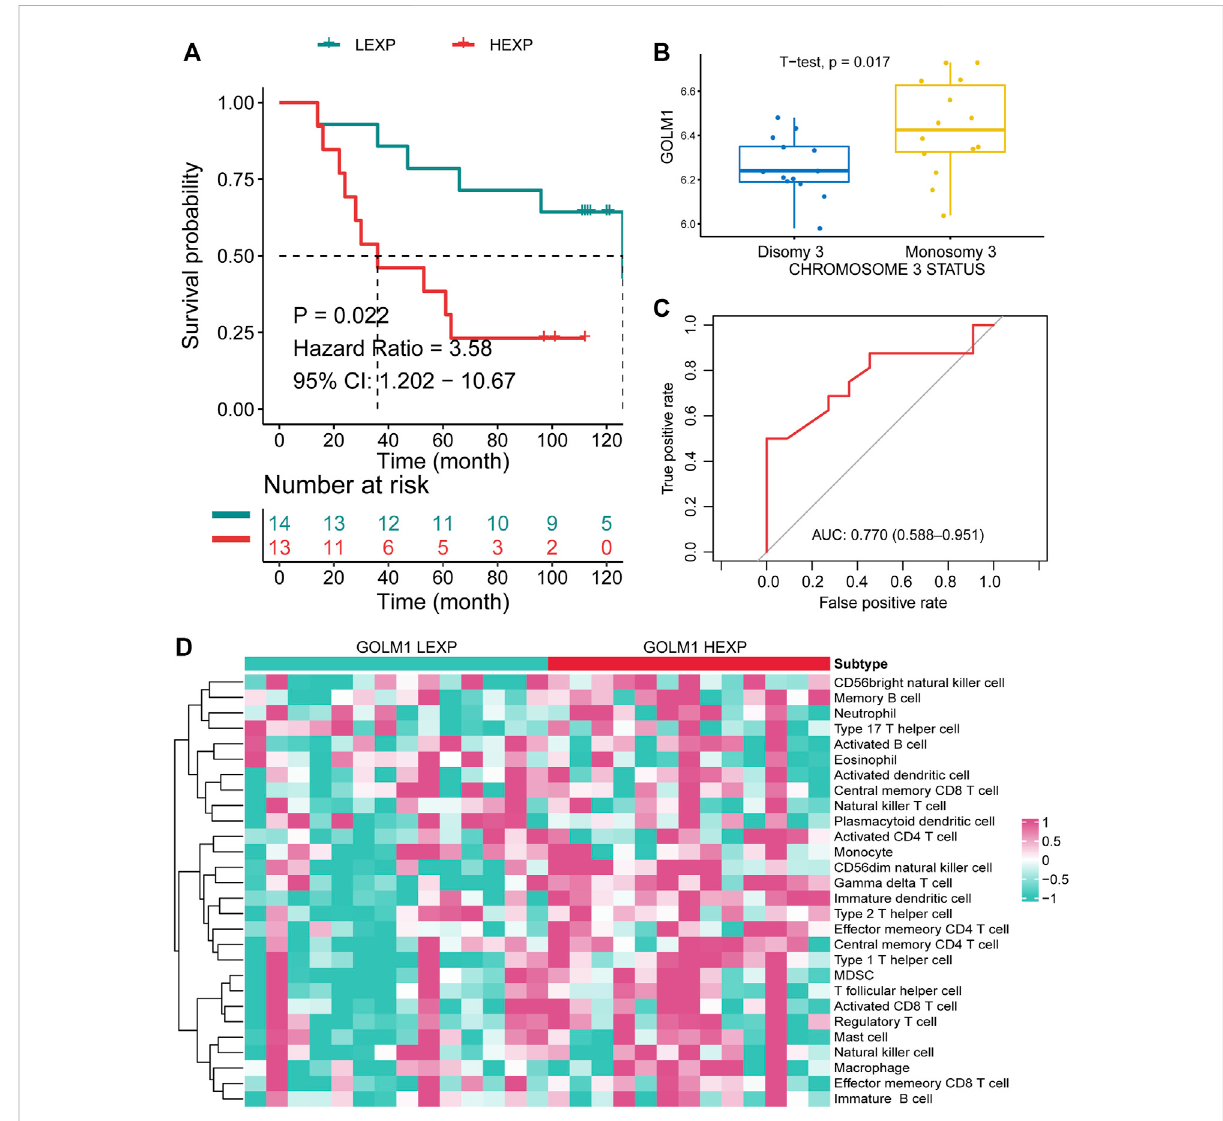
FIGURE 6 Con fi rmation of the prognostic value of GOLM1 in the GSE84976 cohort. (A) Kaplan – Meier curve showing the polarized overall survival in GOLM1-low (LEXP) and GOLM1-high (HEXP) subgroups; (B) Differential expression of GOLM1 in patients with disomy and monosomy chromosome 3; (C) Receiver operating characteristic curve showing the prognostic value of GOLM1; (D) Differential in fi ltration of immunocytes in the LEXP and HEXP